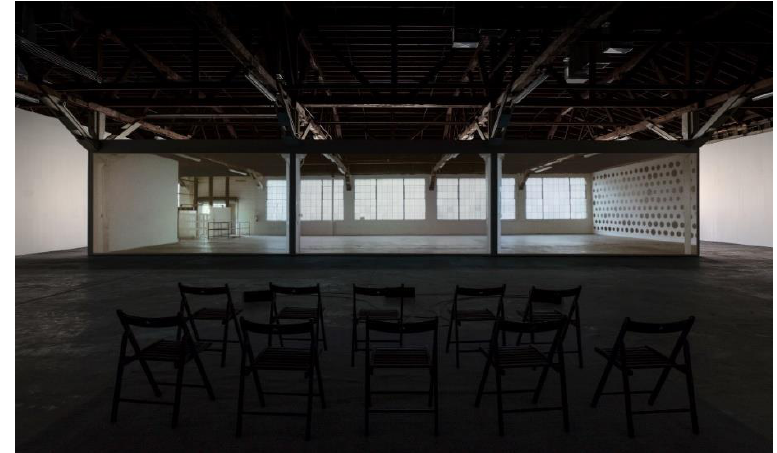
Figure 1. Installation view of Kerry Tribe, The Aphasia Poetry Club (2015), 356 Mission, Los Angeles. Photo: Fredrik Nilsen.